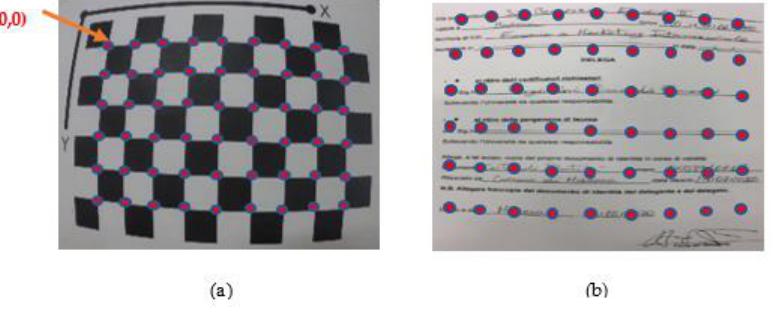
Figure 8. Detecting the corners of checkerboard calibrating pattern in ( a ) and its corresponding warped document in ( b ).